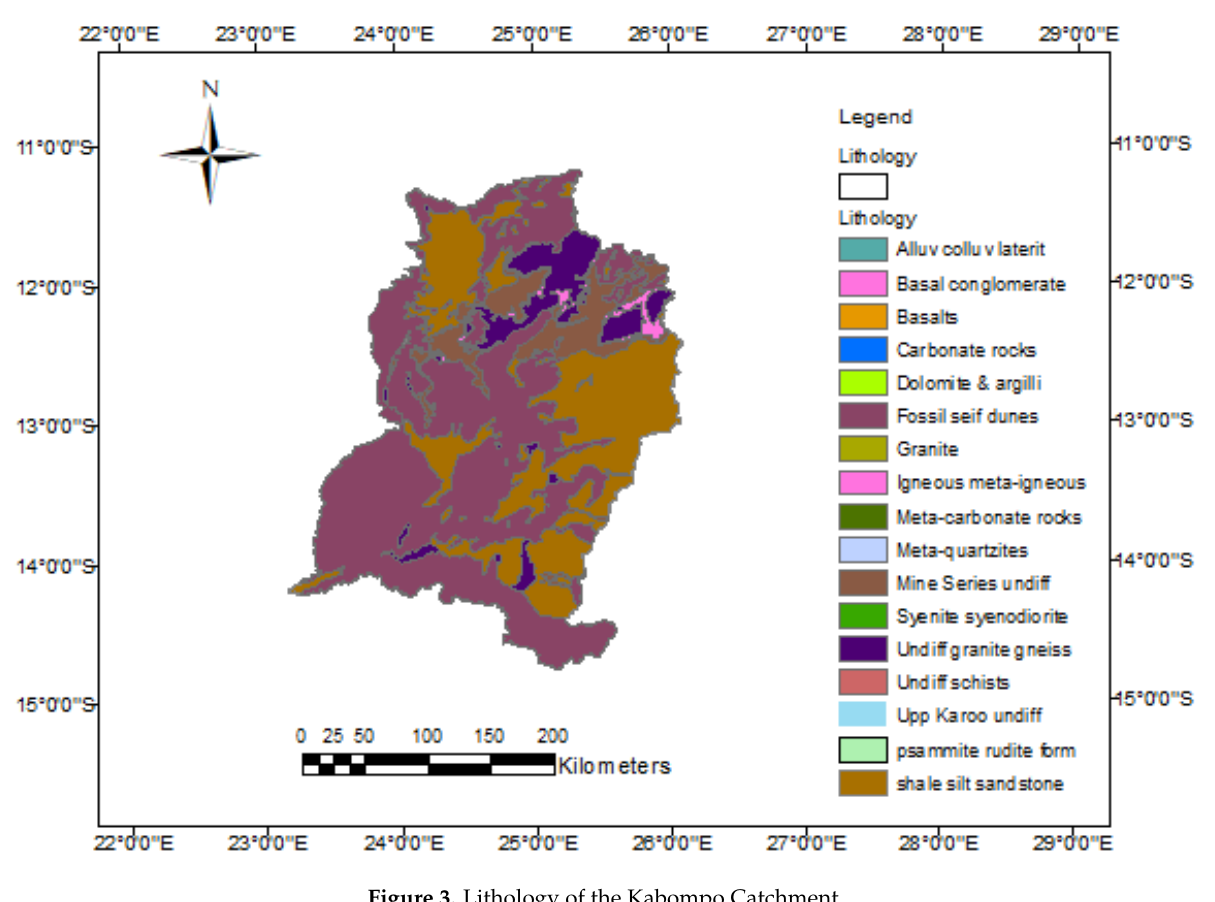
Figure 3. Lithology of the Kabompo Catchment.